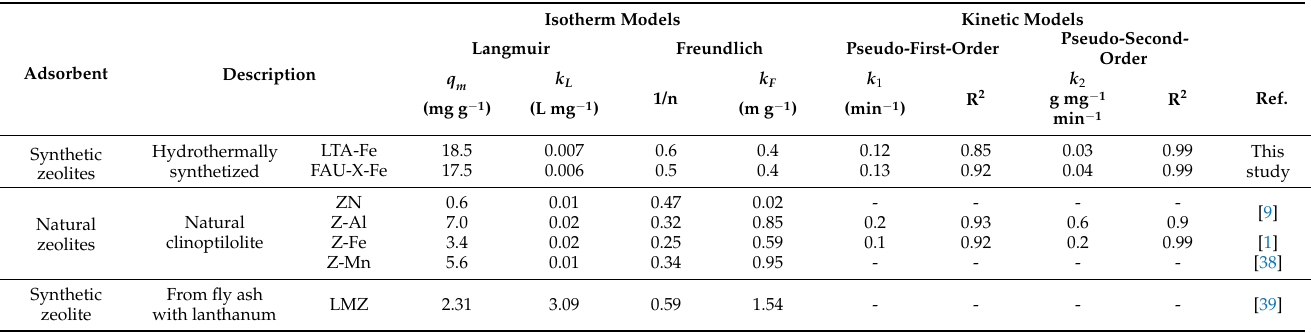
Table 8. Summary of phosphate adsorption capacities of inorganic